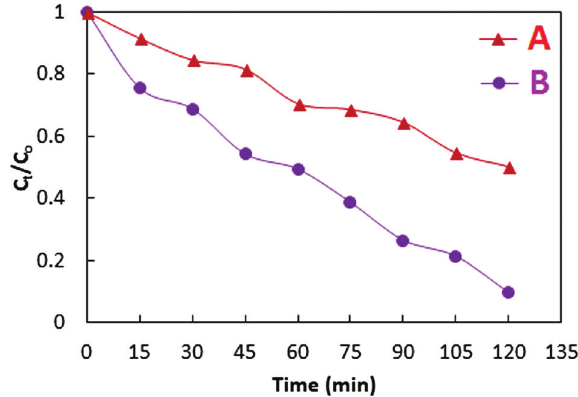
Figure 4b: Photo degradation of Rhodamine B dye catalyzed by TiO (A) and Ag-TiO (B) in aqueous 2 2